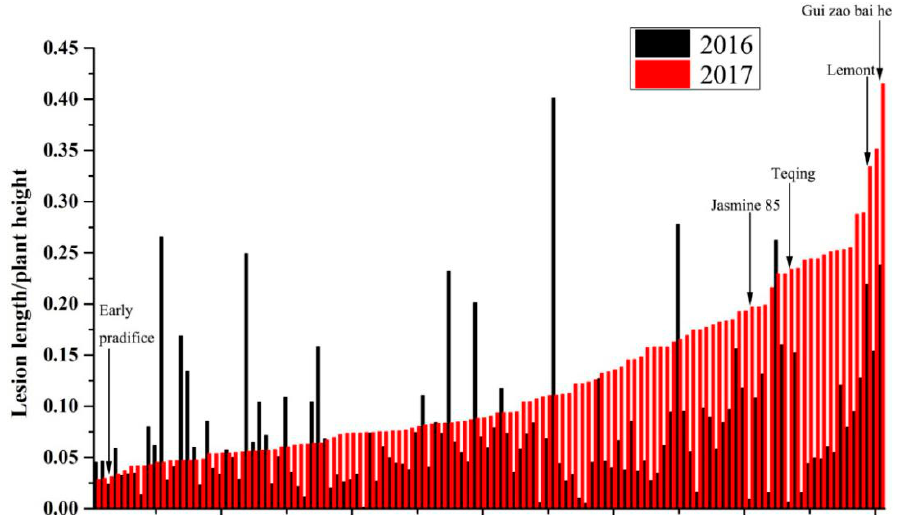
Figure 1. Distribution of ShB resistance (lesion length/plant height) in the Ting’s core collection in 2016 and 2017.